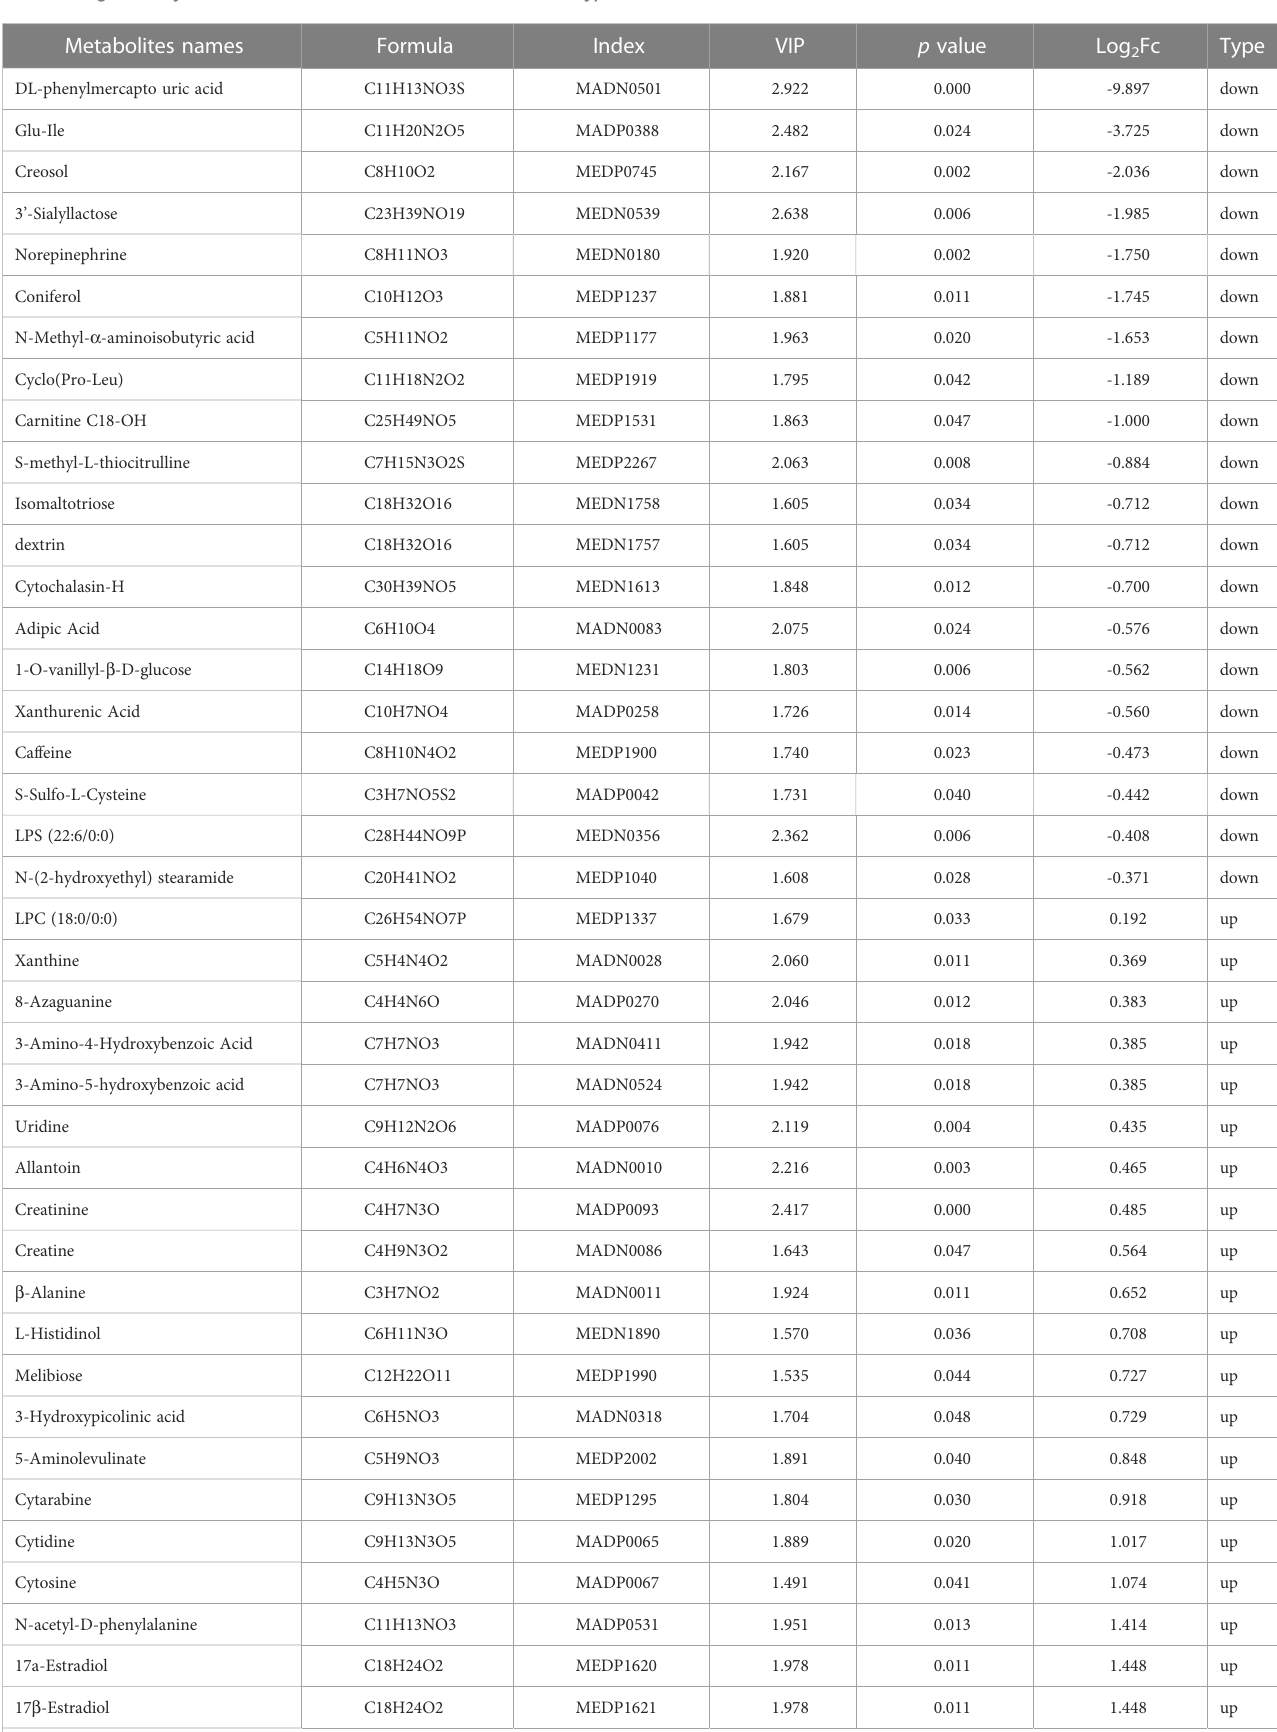
TABLE 1 Signi fi cantly differential metabolites in Ano5 Cys360Tyr vs wild type